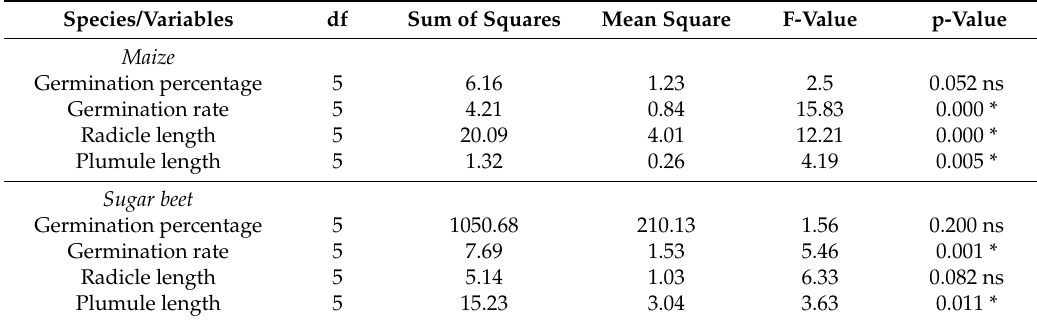
Table 1. Analysis of variance results of the effect of the UV-C radiation treatments on the seeds germination percentage, germination rate, radicle length, and plumule length (one-way ANOVA, p < 0.05); ns and * indicate statistically non-significant and significant differences between the treatments, respectively.